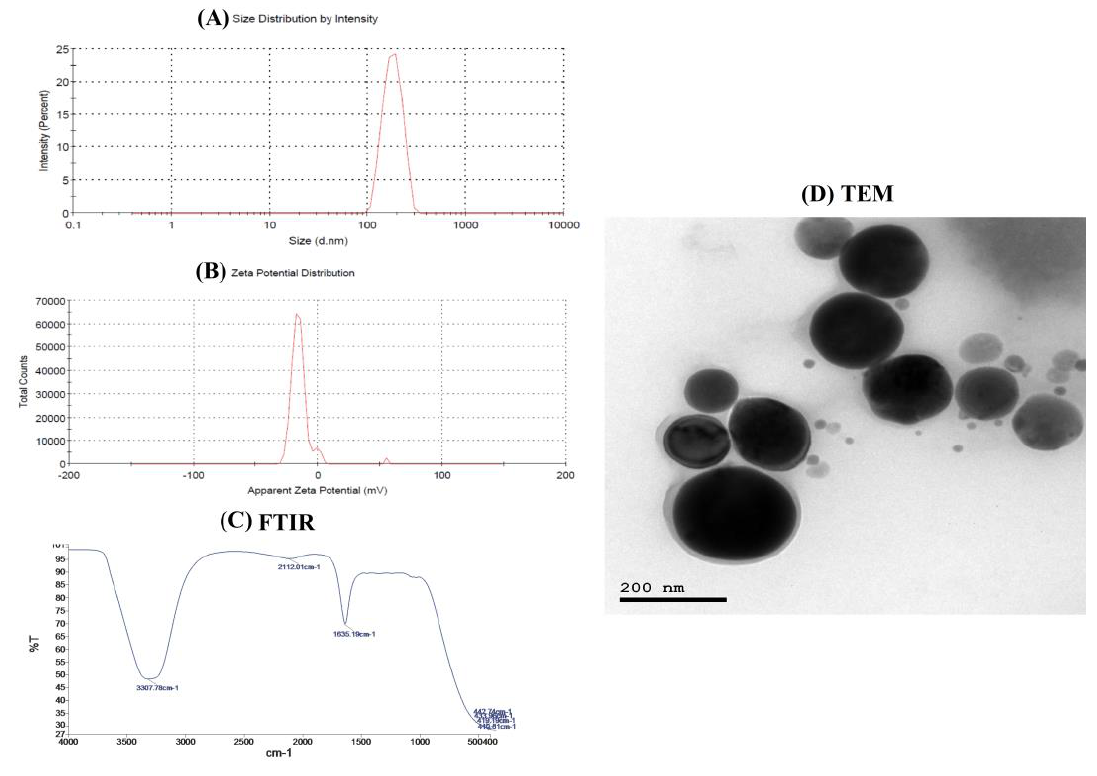
Figure 1. Characterization of Syzygium aromaticum extract coated selenium nanoparticles (SAE-SeNPs). ( A ): Hydrodynamic diameter of SAE-SeNPs by Zetasizer. ( B ): Surface charge of SAE-SeNPs by Zeta potential. ( C ): FT-IR spectra of SAE-SeNPs. ( D ): HR-TEM of SAE-SeNPs.